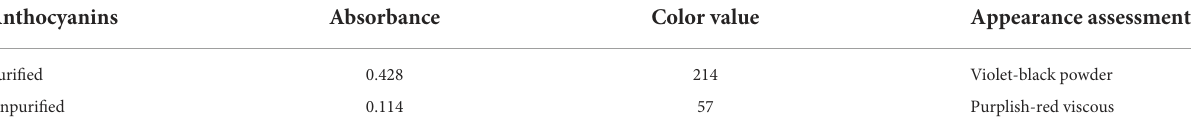
TABLE 4 Comparison of ALRM color value before and after